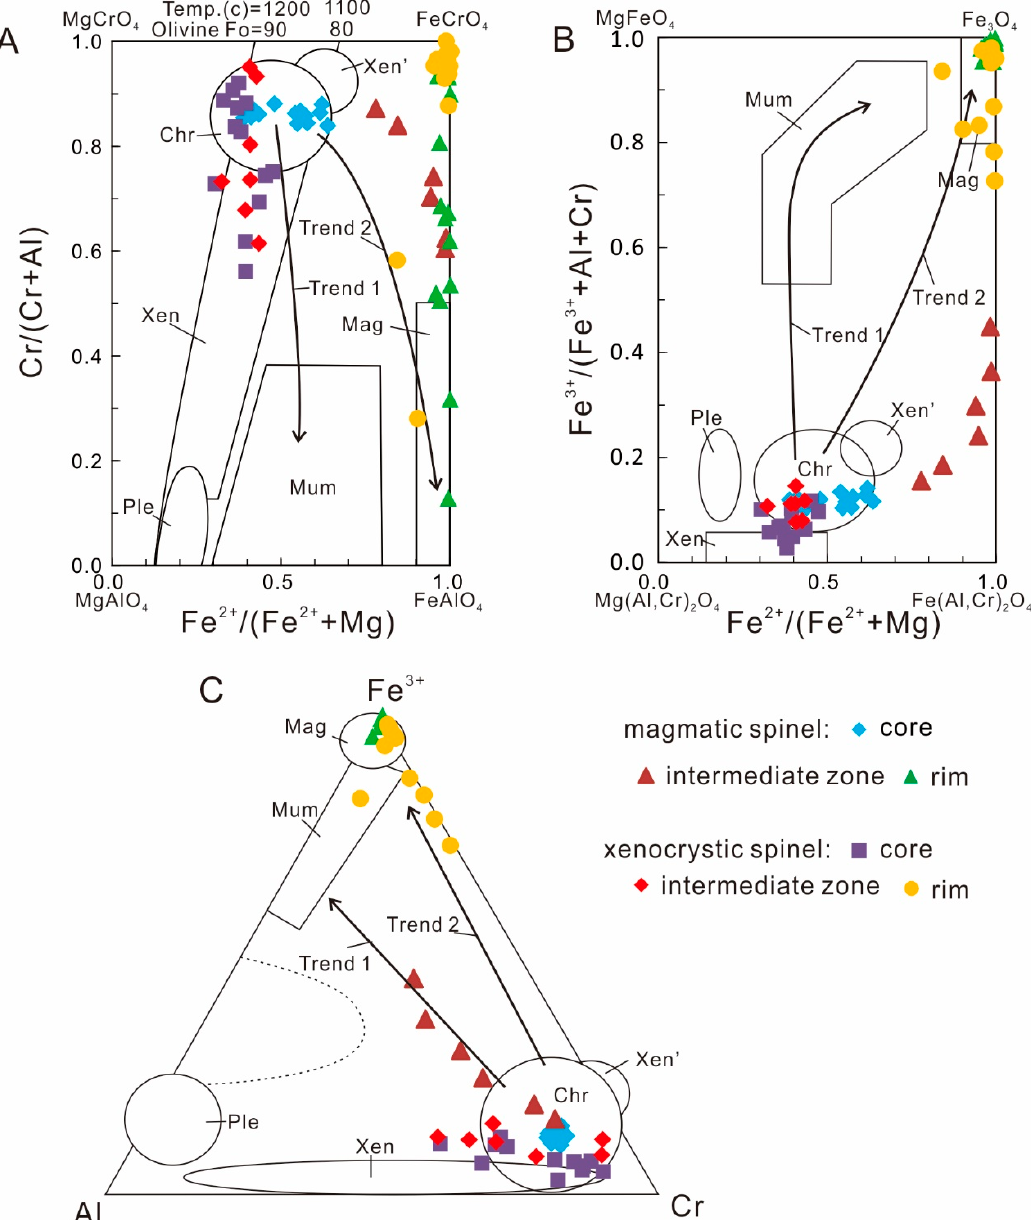
Figure 3. Three spinel projections of oxidized spinel prism for magmatic and xenocrystic spinels from the No.30 kimberlite pipe: ( A ) Cr / (Cr + Al) versus Fe 2 + / (Fe 2 + + Mg), ( B ) Fe 3 + / (Fe 3 + + Al + Cr) versus Fe 2 + / (Fe 2 + + Mg) and ( C ) Fe 3 + -Al-Cr. The iso-potential lines (dotted lines) indicating that the composition of the spinels that is in equilibrium with olivine (Fo 90 and 80) at a constant temperature of 1200 ◦ C and 1100 ◦ C is after Irvine (1965). Curves of trend 1 and trend 2 are after Mitchell [22] and Roeder and Schulze [23]. Abbreviations: Xen = xenocryst peridotite spinel; MUM = magnesium-ulvöspinel-magnetite; Chr = chromite; Xen’ = Metasomatized xenocryst peridotite spinel; Mag = magnetite.